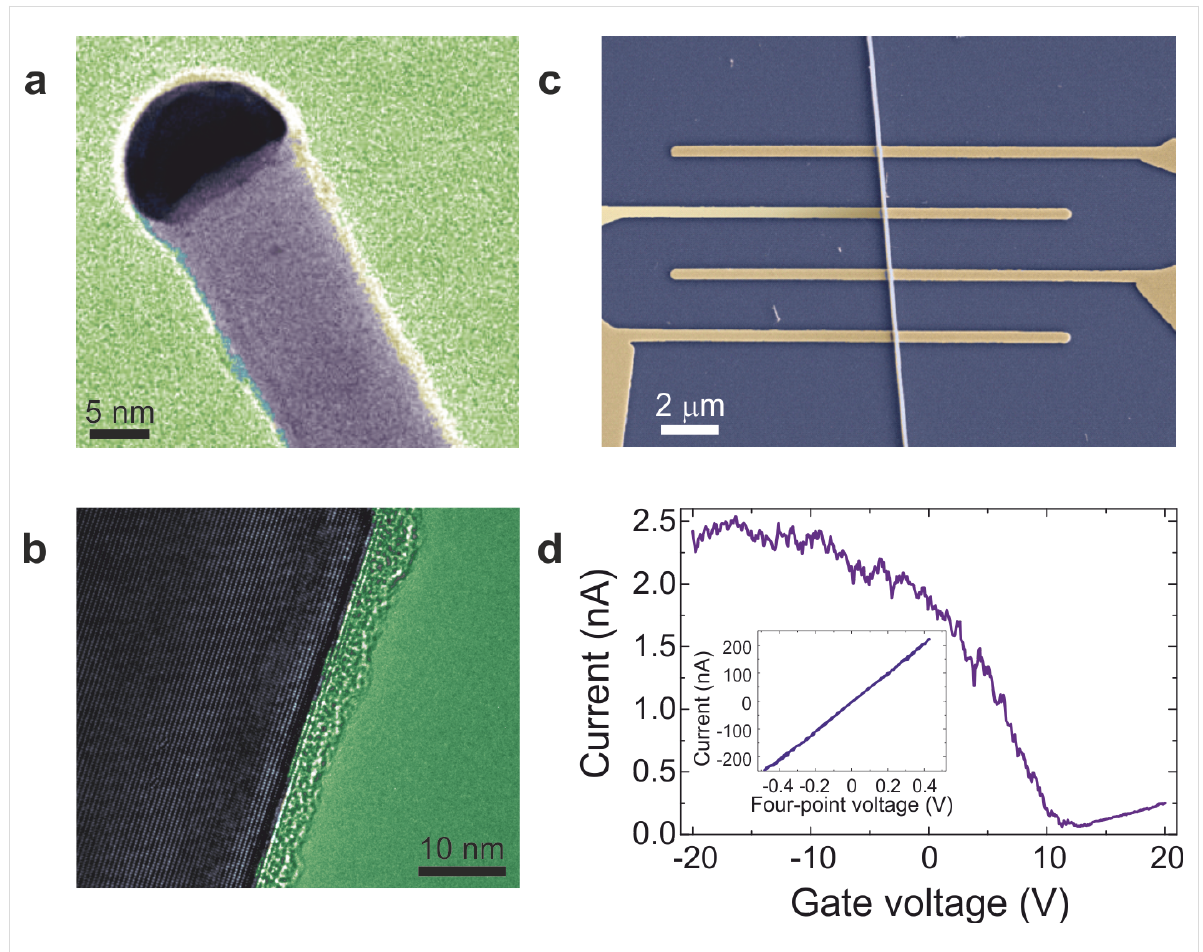
Figure 1: Characterization of Au-seeded Ge NWs. (a) TEM image of a Ge NW with an Au nanoparticle at the tip. (b) Higher magnification TEM image showing a NW with uniform crystalline structure covered by a thin native oxide layer. (c) SEM image of a four-terminal Ge NW device fabricated with 200 nm wide electrodes on top of a 30 nm radius wire. (d) Transfer curve taken at 0.5 V source-drain voltage for a 28 nm radius wire revealing p -type charge transport. Inset: four-point current–voltage characteristic of the same